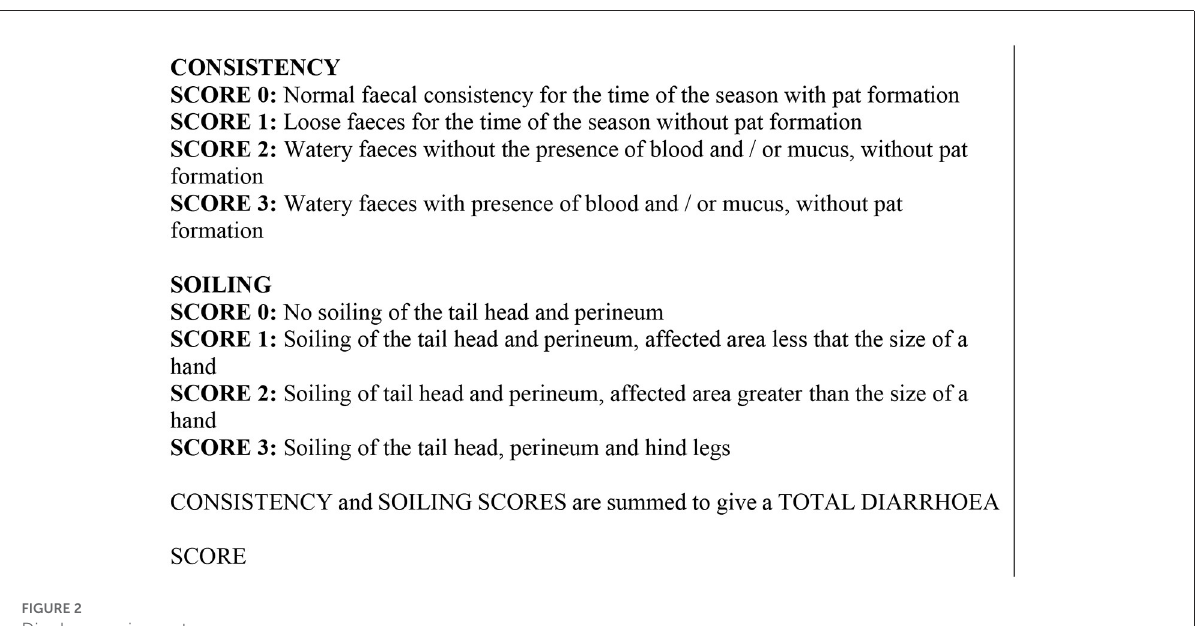
FIGURE2 Diarrhea scoring